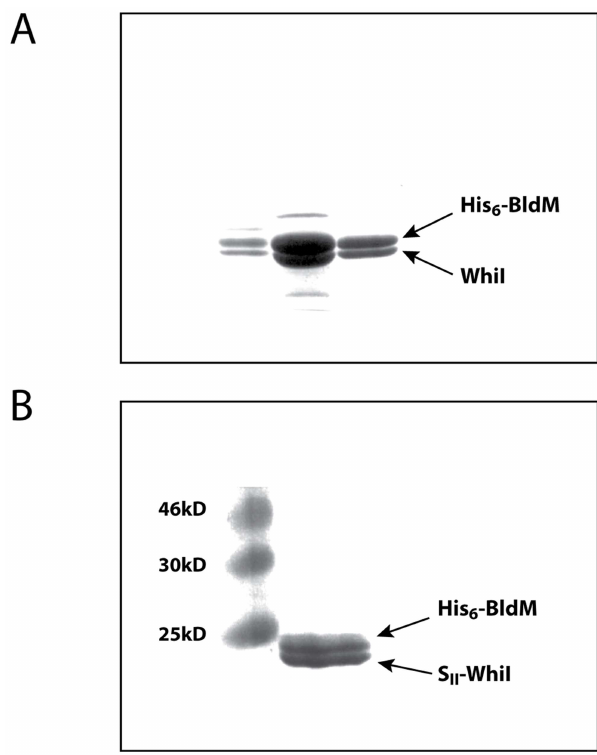
Figure 5. Affinity purification of the BldM-WhiI complex. N- terminally His 6 -tagged BldM and either (A) untagged WhiI, or (B) N- terminally S II -tagged WhiI, were co-expressed from the pETDuet-1 vector. In both cases, co-expression of BldM solubilized WhiI, which formed inclusion bodies when expressed alone. The His 6 -BldMWhiI complex in (A) was purified over a HisTrap Ni affinity column, and the His 6 -BldM-S II -whiI complex in (B) was purified over consecutive HisTrap Ni and StrepTrap HP affinity columns.